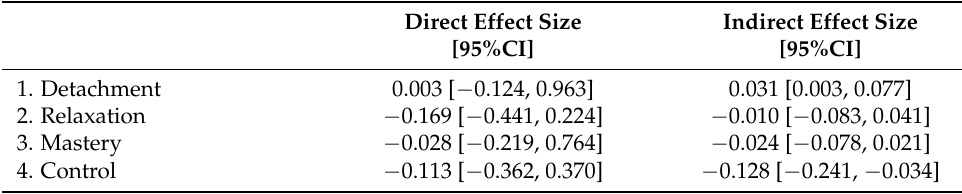
Table 2. Testing the indirect effects of recovery experiences on gaming addiction.